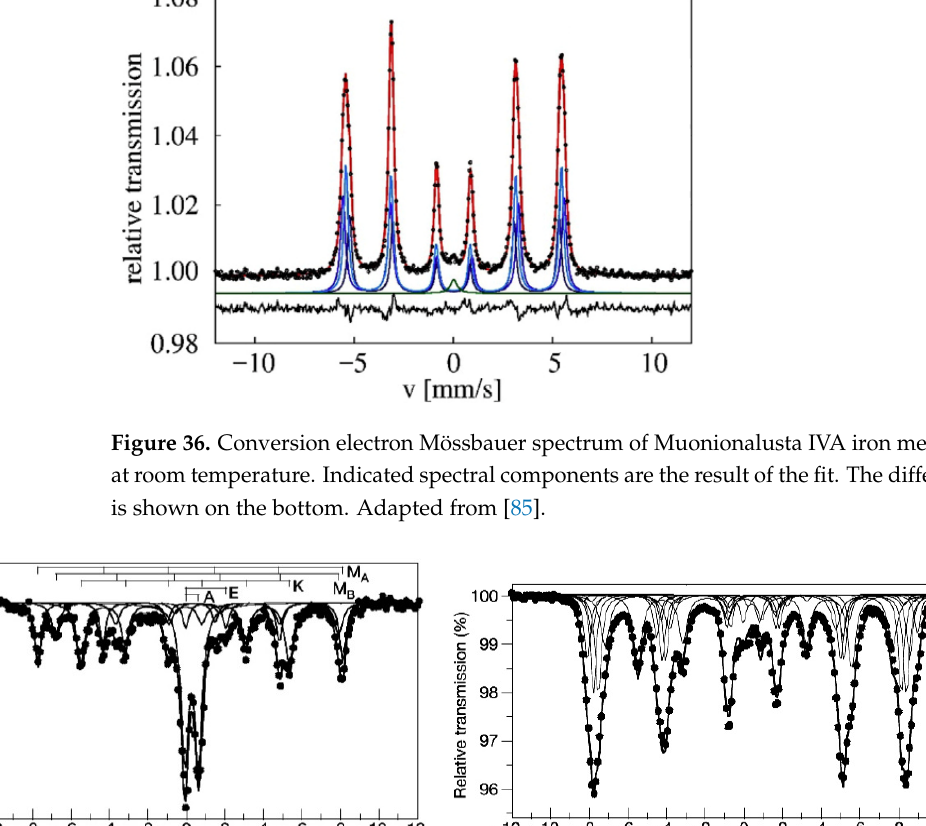
Figure 35. Room temperature synchrotron Mössbauer spectra of the Tazewell IAB-sLH iron meteorite selected areas: cloudy zone ( a ) and plessite area ( b ). Indicated spectral components are the results of the fits. The differential spectra are shown on the top. Adapted from [43].